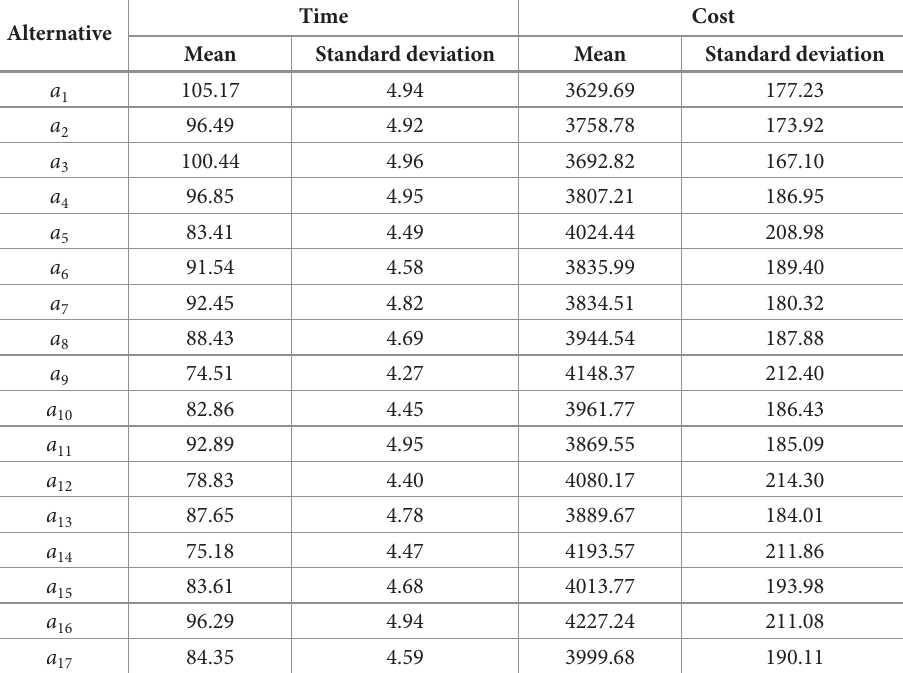
Table 3. Results of simulation experiments Time cost alternative mean standard deviation mean standard